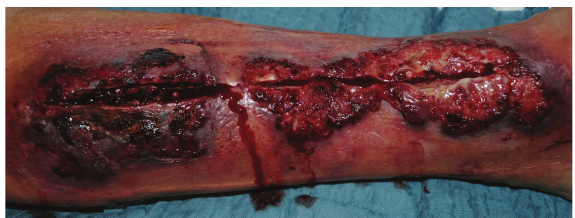
Figure 1: Post-saphenectomy wound complication before debride- ment: Infected hematoma and complete dehiscence of the cuta- neous suture line.